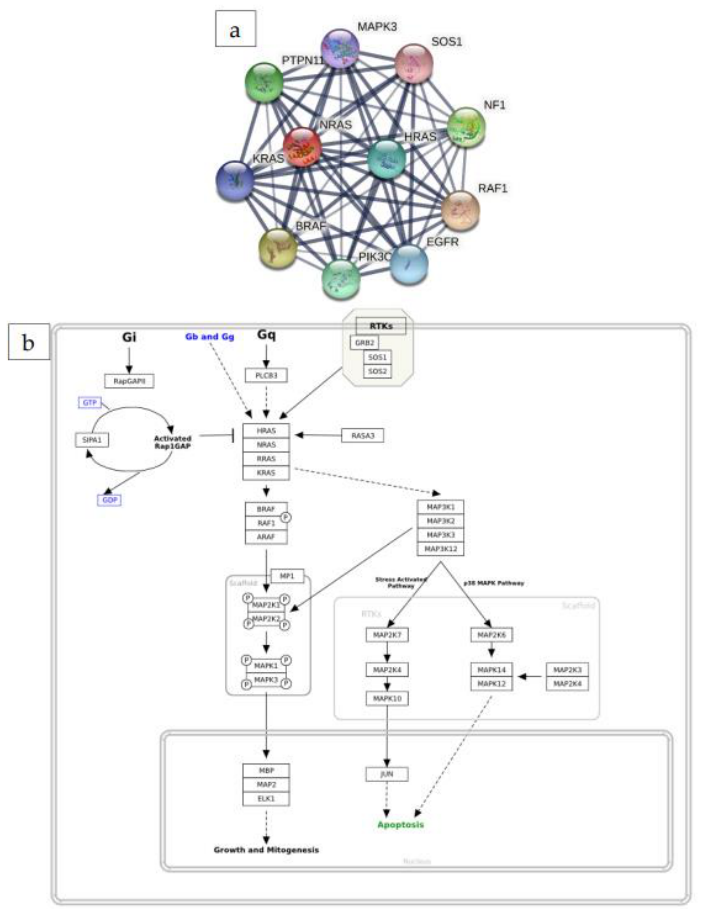
Figure 2. PPI and molecular network analysis. ( a ) The interaction of NRAs with ten partners, and ( b ) the molecular network analysis. 2.4. Prognosis of NRS in EC Malignancy A Kaplan – Meier plotter was used to determine the prognostic value of the NRAS gene by combining gene expression and EC cancer patient survival. The analysis showed a hazard ratio (HR) = 0 and logrank p -value = 0.028 for EC cancer (Figure 3).